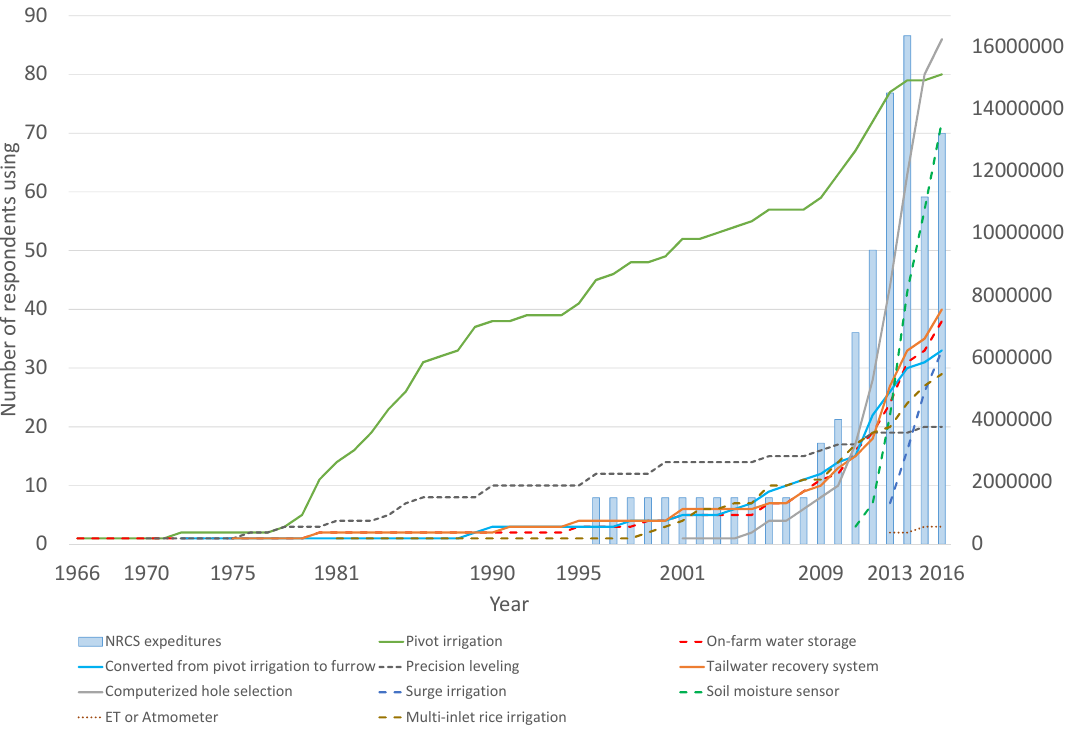
Figure 1. Timeline of the adoption of conservation practices and USDA-NRCS EQIP expenditures in the MS Delta area. Table 8. Impact of conservation practice adoption factors compared to existing literature. Factor Results Nian et al. Prokopy et